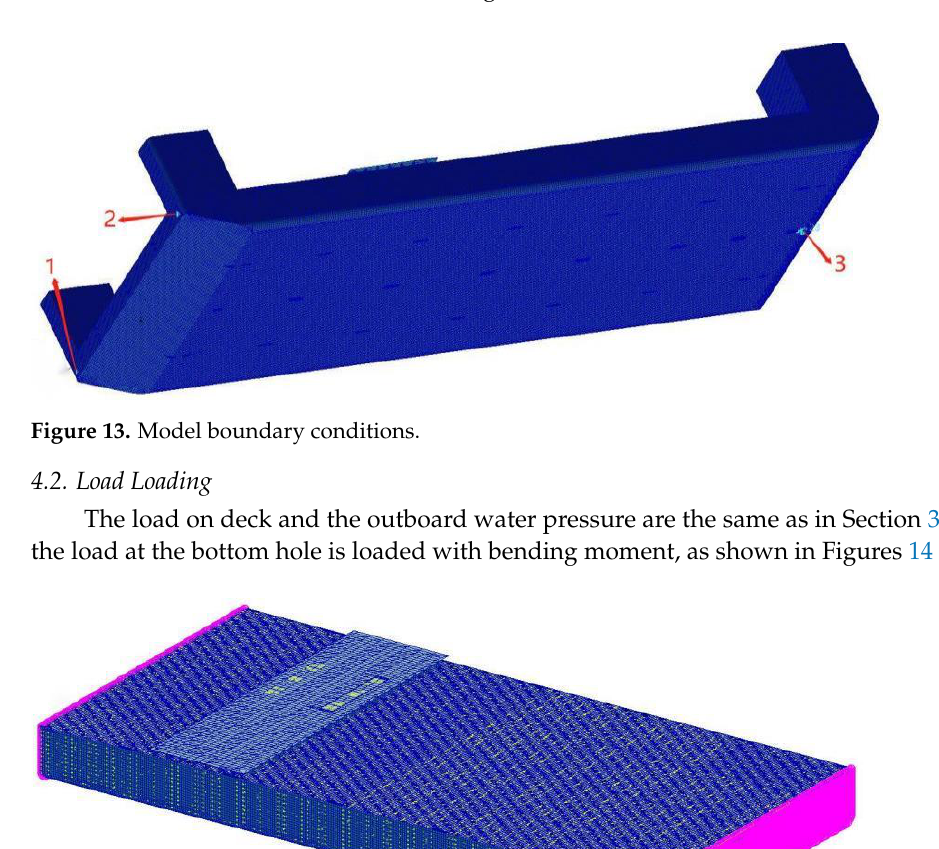
Figure 14. Schematic diagram of finite element model with multipoint constraints.